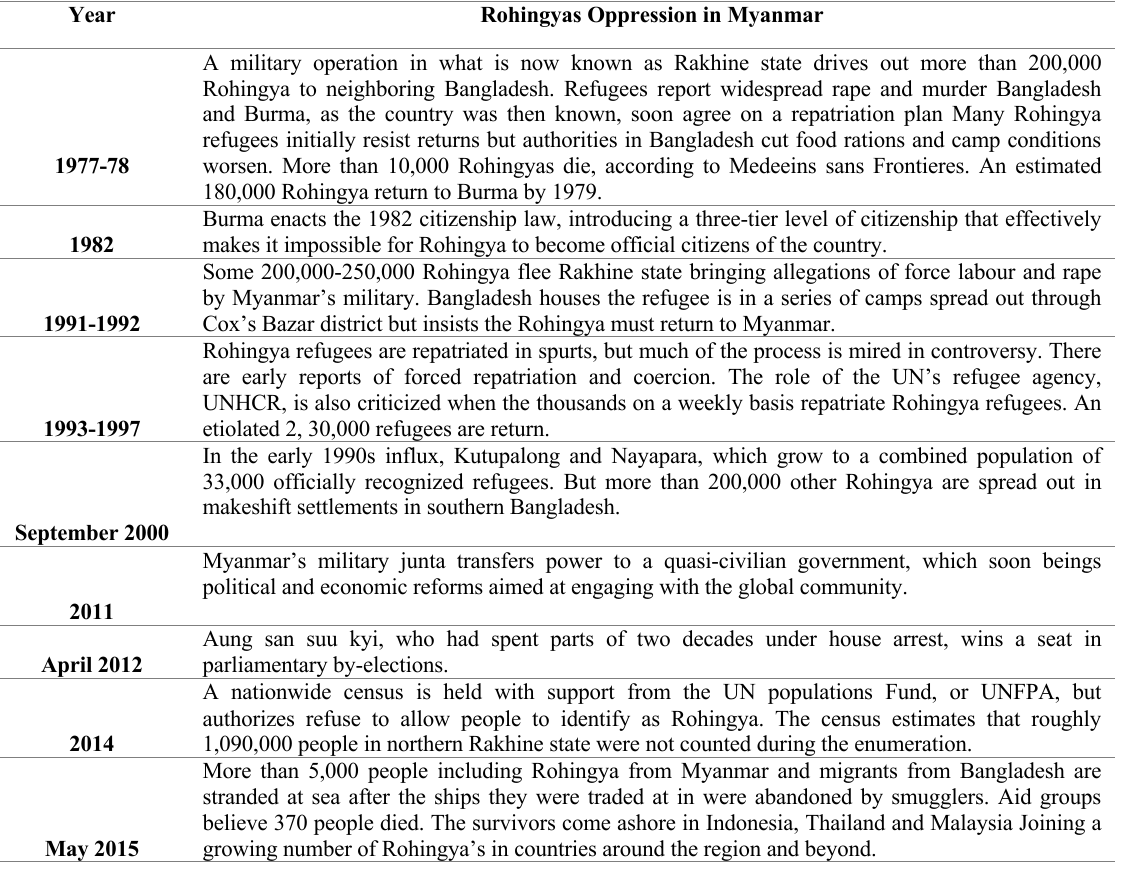
Table 6: Trends of Myanmar